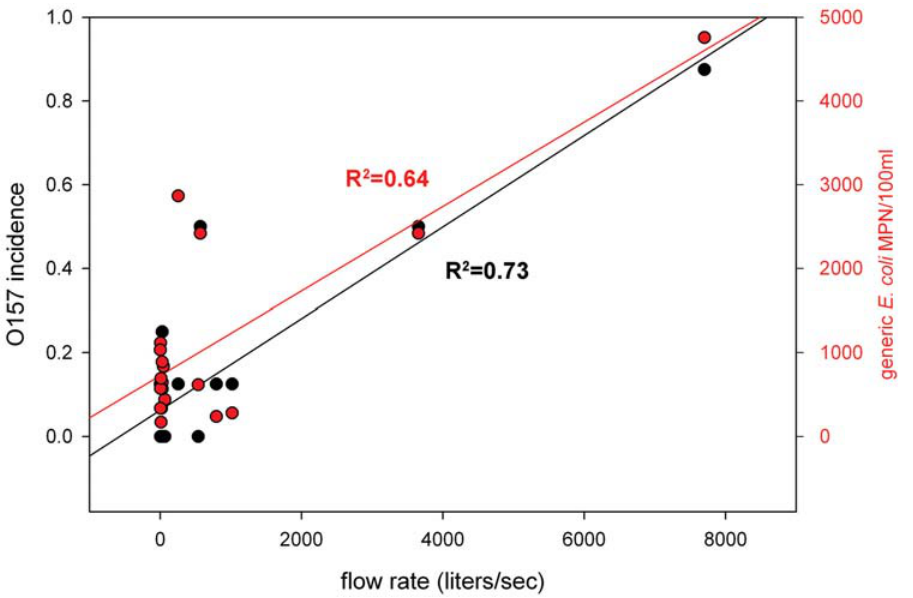
Figure 2. Correlation of water flow, the concentration of generic E.coli, and the incidence of EcO157 in the Gabilan Creek (Salinas, CA). Linear regression R 2 values are indicated. EcO157 incidence is calculated as the fraction of the number of positive samples compared to the total samples obtained. The flow rate was obtained from data from the USGS sampling station # 11152600 located at position D (see Figure 1). EcO157 incidence and generic E. coli concentration were determined with duplicate samples.